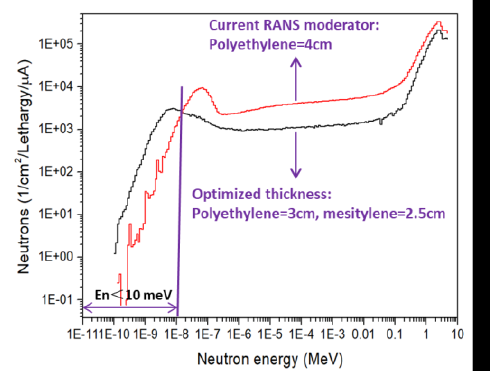
Fig. 5. Neutron spectrum of the RANS current moderator and for an optimized cold moderator